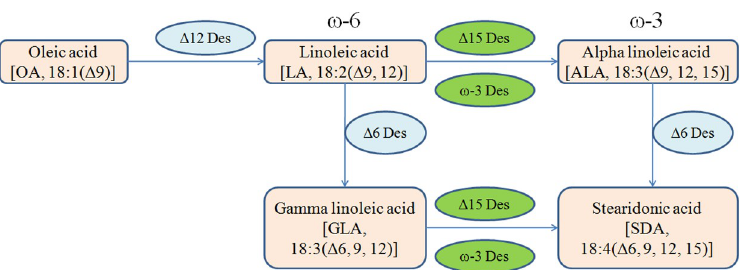
Figure 1. Metabolic pathway of linoleic acid (LA) flux into n-6 or n-3 PUFAs to produce stearidonic acid (SDA).